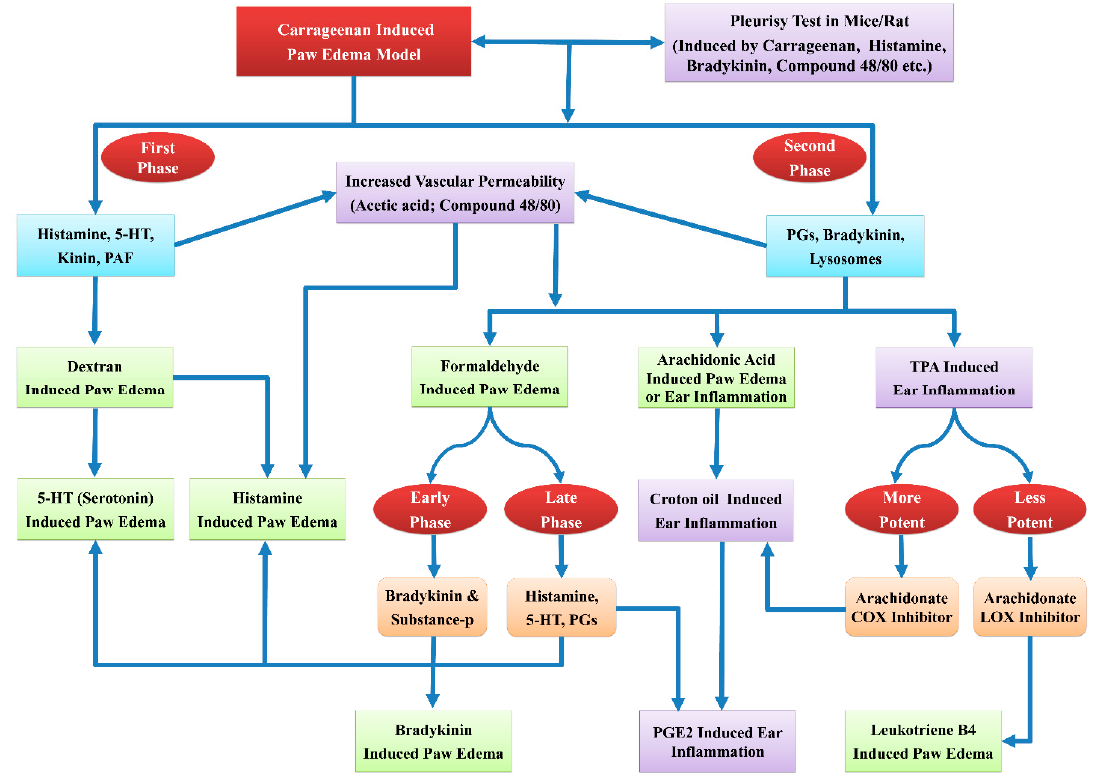
Figure 4. Scheme for the preclinical evaluation of the acute anti-inflammatory activity.